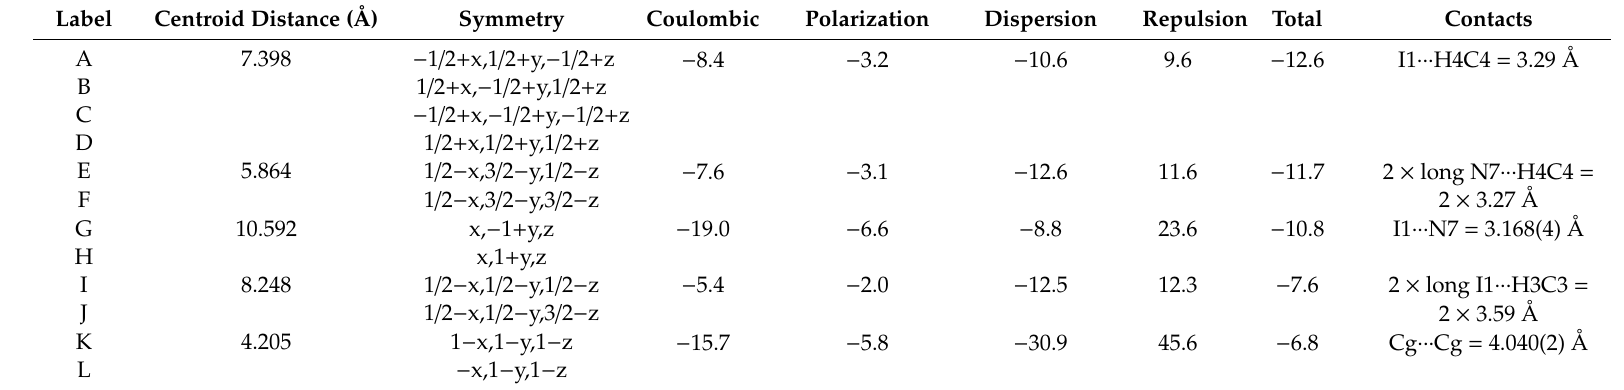
Table 1. PIXEL calculated dimer interaction energies of the phase I polymorph at 0.0 GPa. All energies are in kJ mol − 1